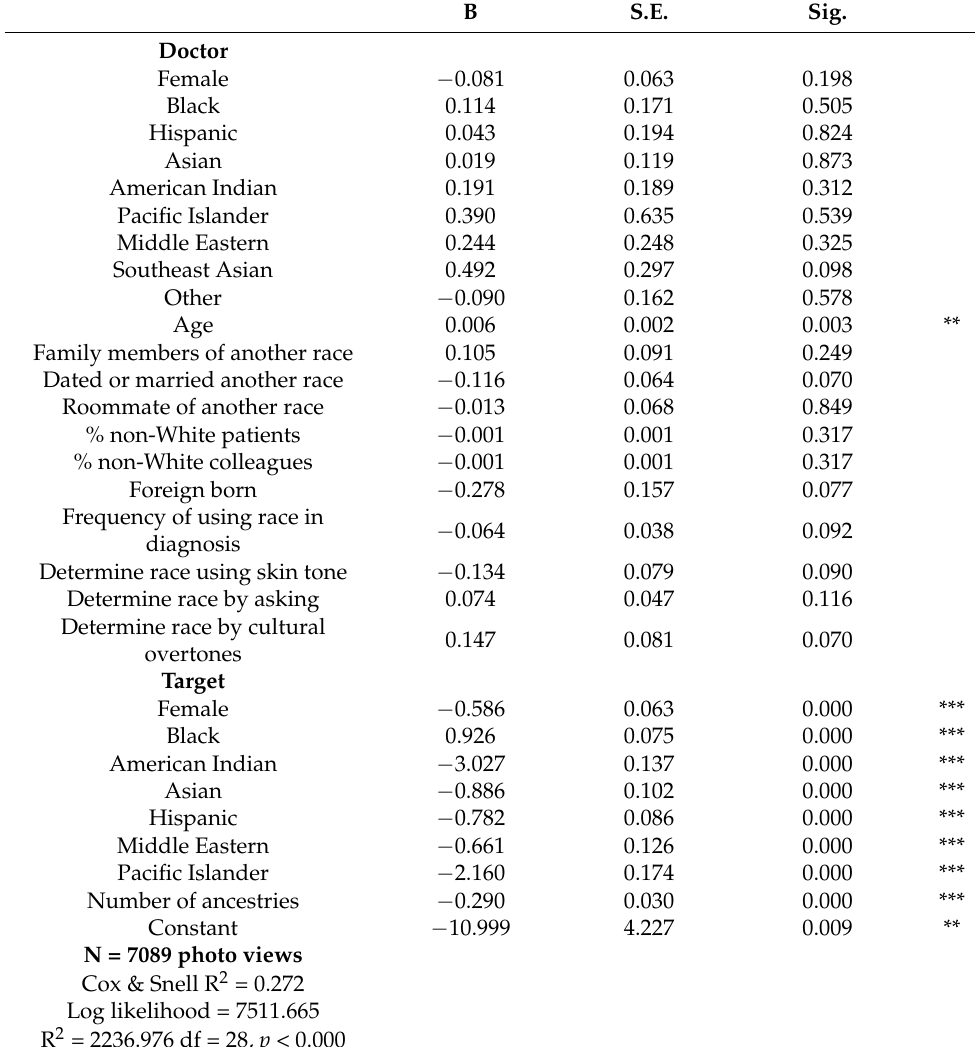
Table 5. Logistic regression of Type 1 congruence on doctor and target characteristics.